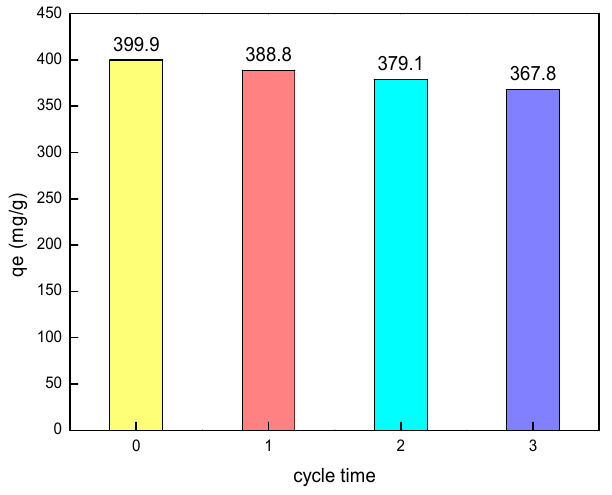
Figure 9. Regeneration performance of SL by hierarchical hydrotalcite.